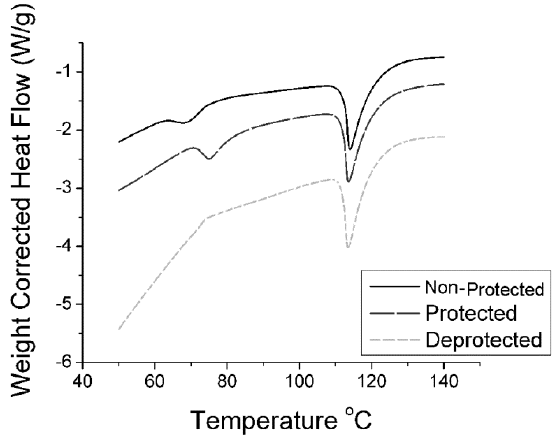
Figure 1. DSC spectra of n-propyl urea isolated from all three amine starting materials. Ramp rate = 5 °C per minute to 140 °C followed by equilibration to 60 °C and repeated